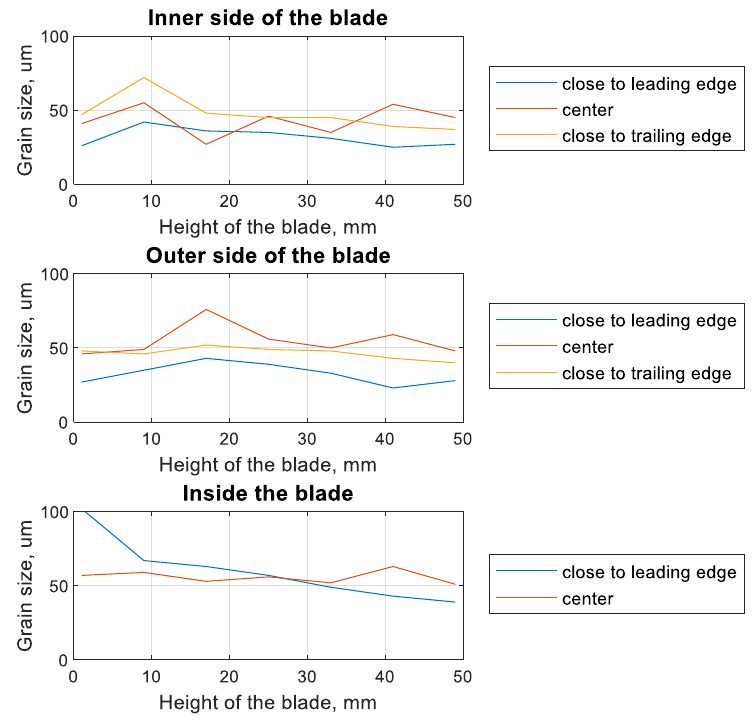
Figure 8. Plots of the grain size (in the layer plasticized by shot-peening) as a function of the height of the blade for different measurement